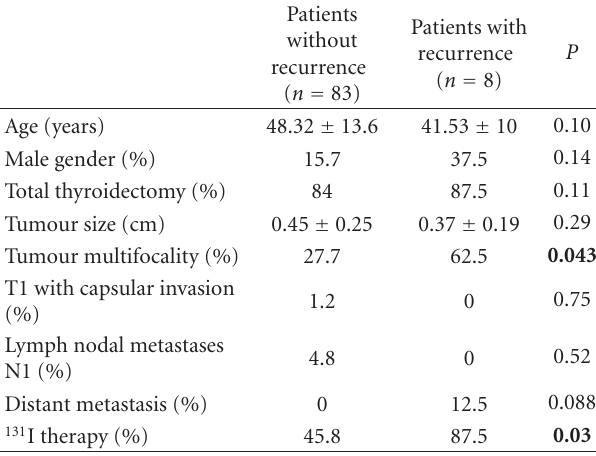
Table 3: Comparison between the main characteristics of patients without or with tumour recurrence.